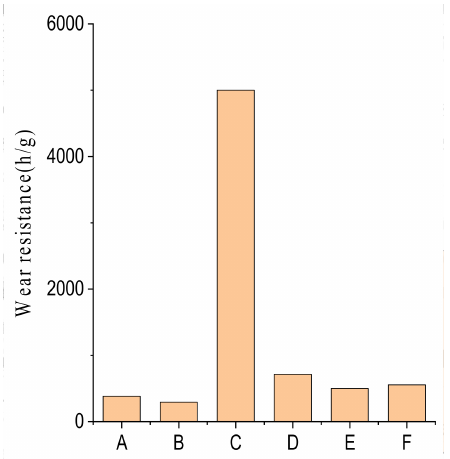
Figure 7. Abrasion resistance values for calcined bauxites.